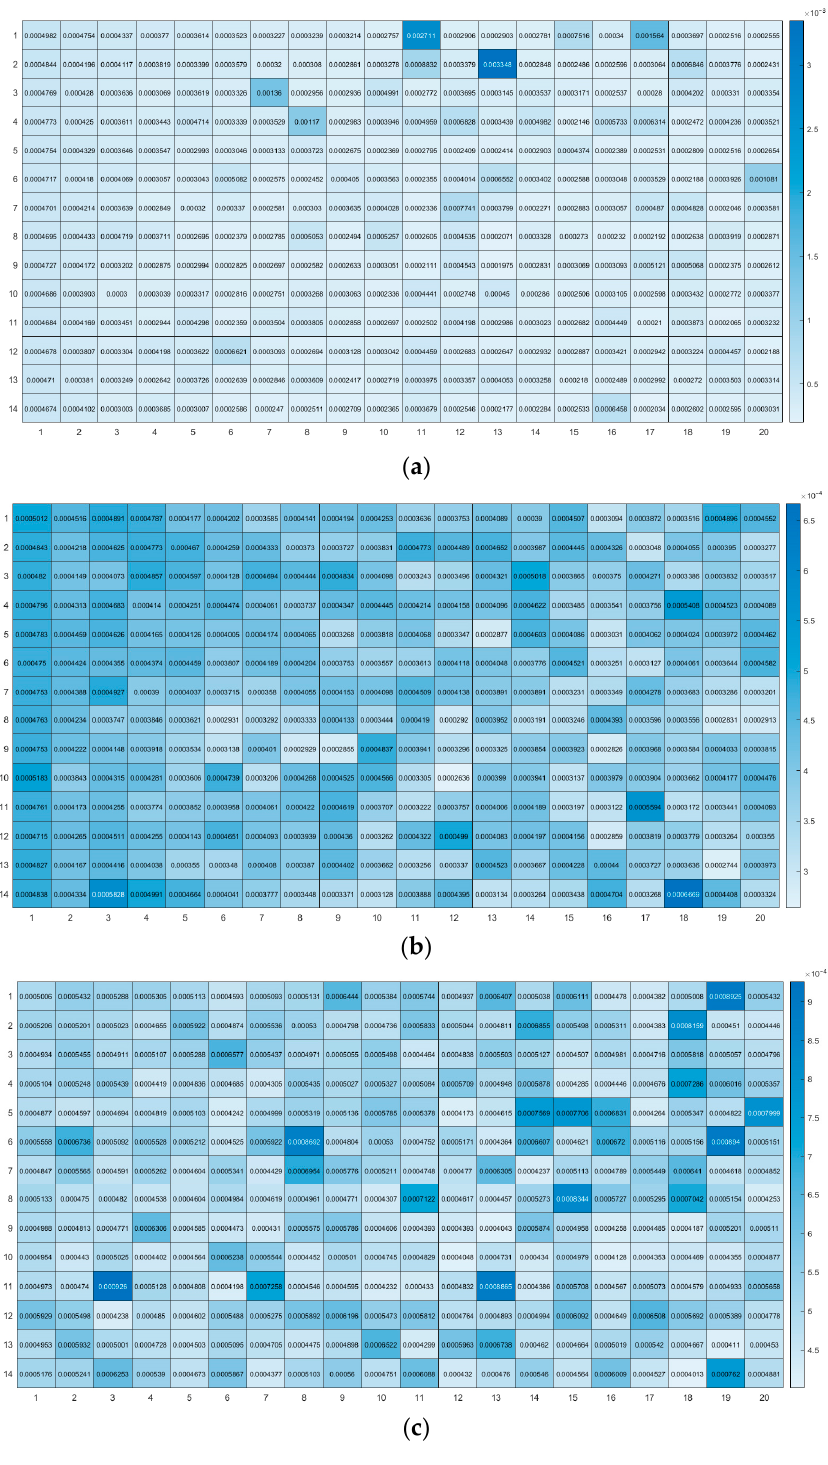
Figure 5. Thermal diagram of the mean square errors obtained by different training algorithms under different combinations of the time delay and the hidden neurons number: ( a ) use of BR as the training algorithm, ( b ) use of LM as the training algorithm, and ( c ) use of SCG as the training algorithm.